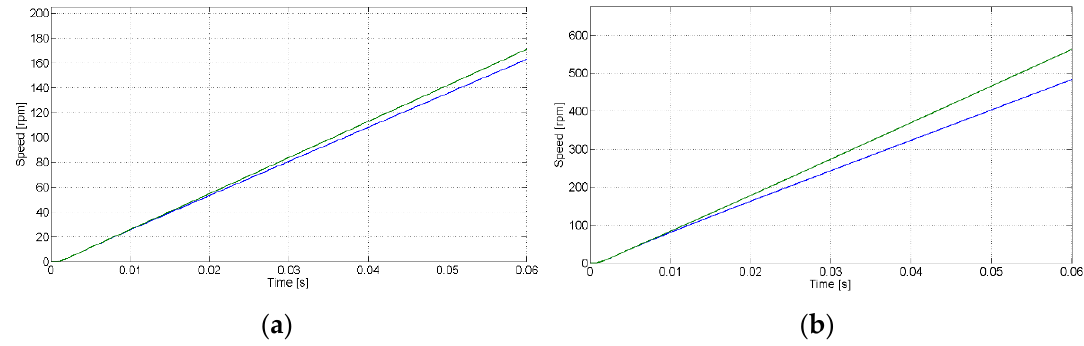
Figure 10. Simulation results: ( a ) actual rotor speed for torque-producing stator current without decoupling according to Figure 8a (blue) and with decoupling according to Figure 9a (green), total moment of inertia J t = 0.043 kgm 2 (including DC machine); ( b ) actual rotor speed for torque-producing stator current without decoupling according to Figure 8b (blue) and with decoupling according to Figure 9b (green), total moment of inertia J t = 0.013 kgm 2 (induction motor only).